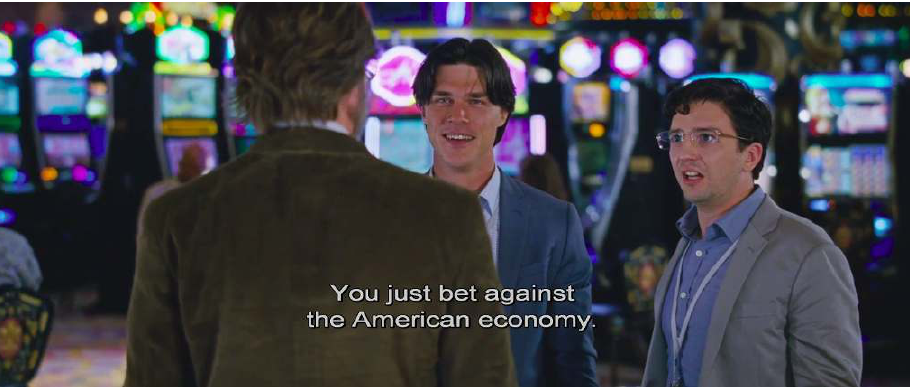
Figure 4: A passive moral figure (Brad Pitt as Ben Rickert facing two hapless characters) in The Big Short , by Adam McKay.